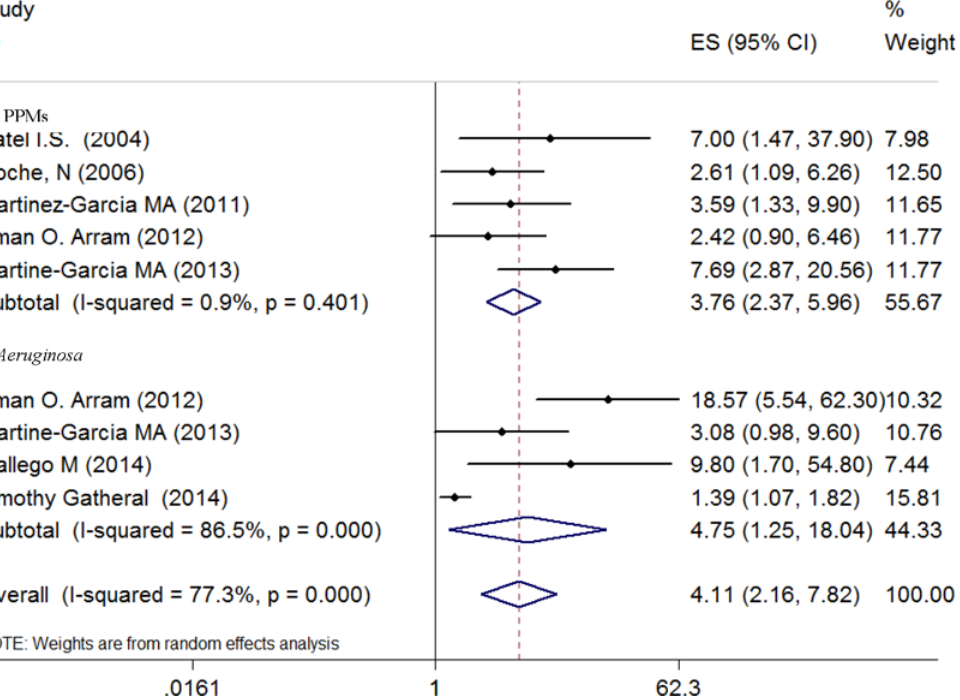
Fig 3. Odd ratios for the association between comorbid bronchiectasis and risk for isolation of a potentially pathogenic microorganism.